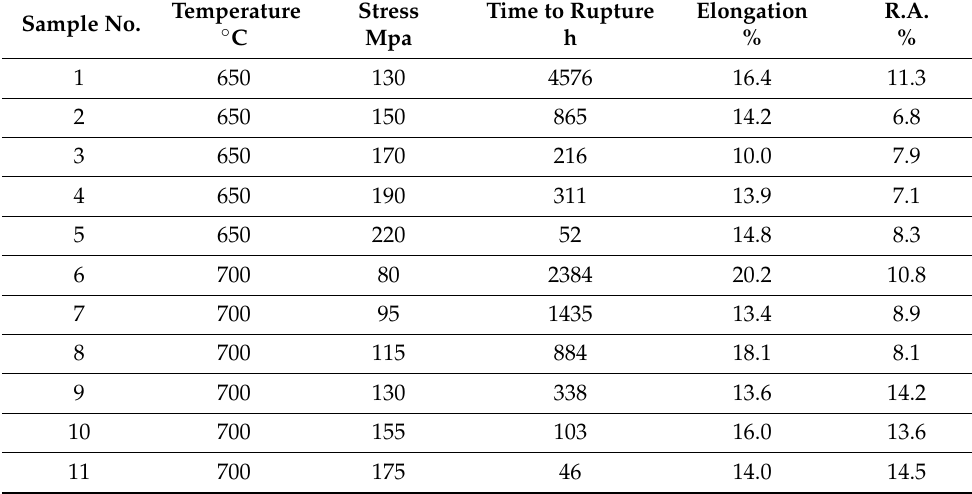
Table 3. Results of stress rupture tests of selective laser melting AISI 316L steel plate. Sample No.